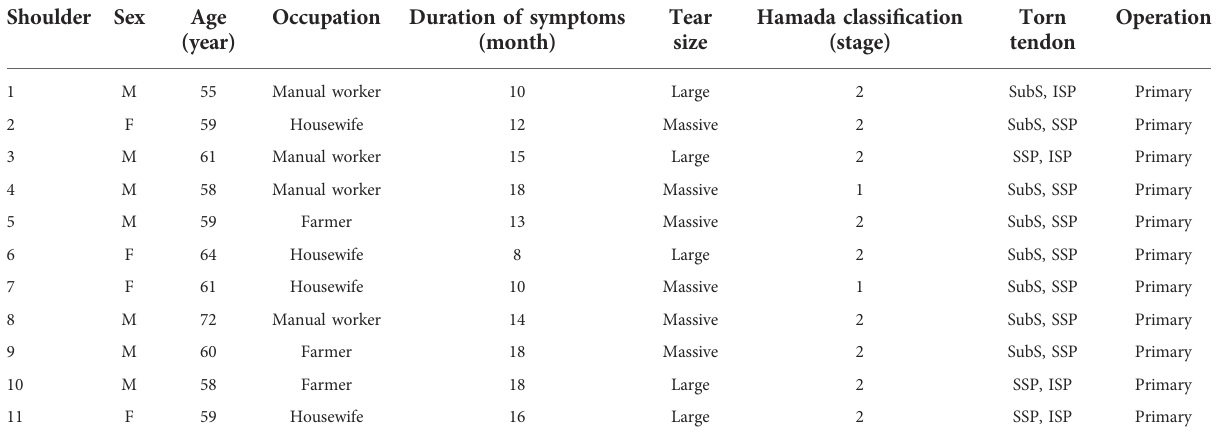
TABLE 1 Summary of